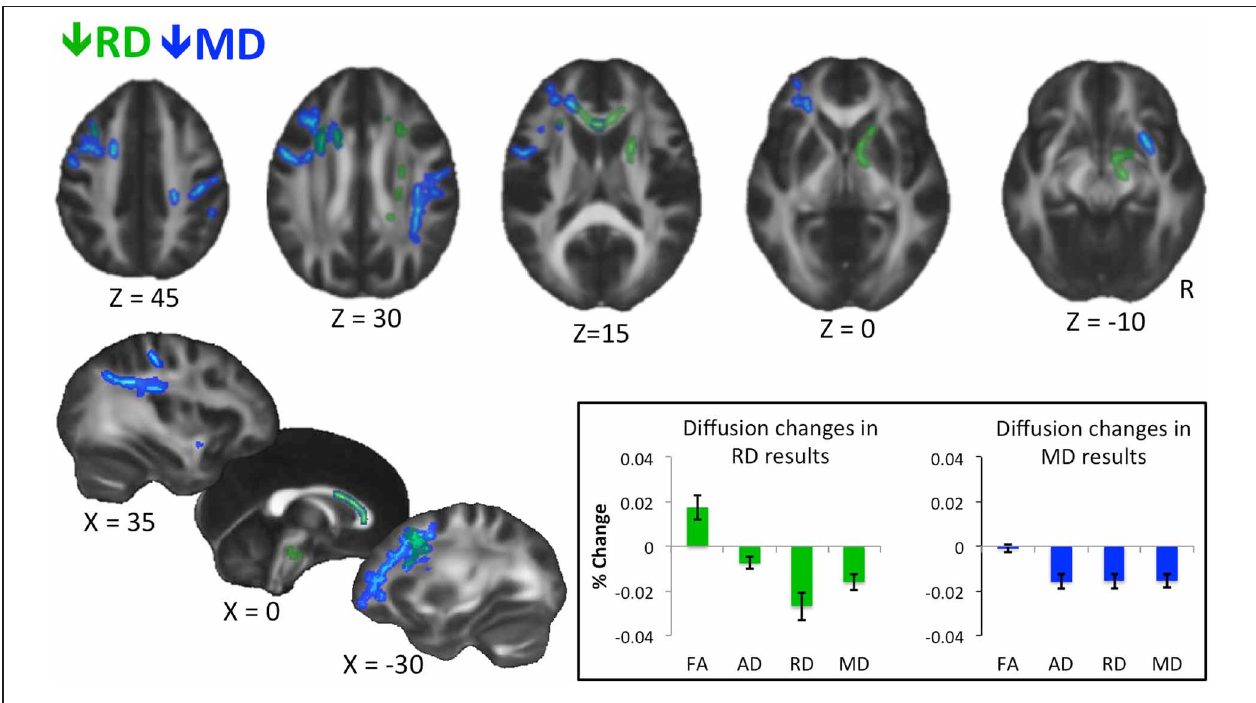
FIGURE 1 | Results of whole-brain voxel-wise statistics. Decreases in RD are shown in green, and decreases in MD are shown in blue. Statistics were performed on skeletonized images, and results were filled for visualization purposes. Results are thresholded at P < 0 . 05, corrected for multiple comparisons with threshold-free cluster enhancement (Smith and Nichols, 2009). Inset shows percent change in diffusion measures extracted from